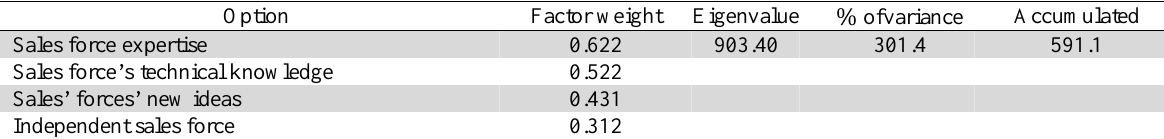
The summary of factors associated with sales force’s capability